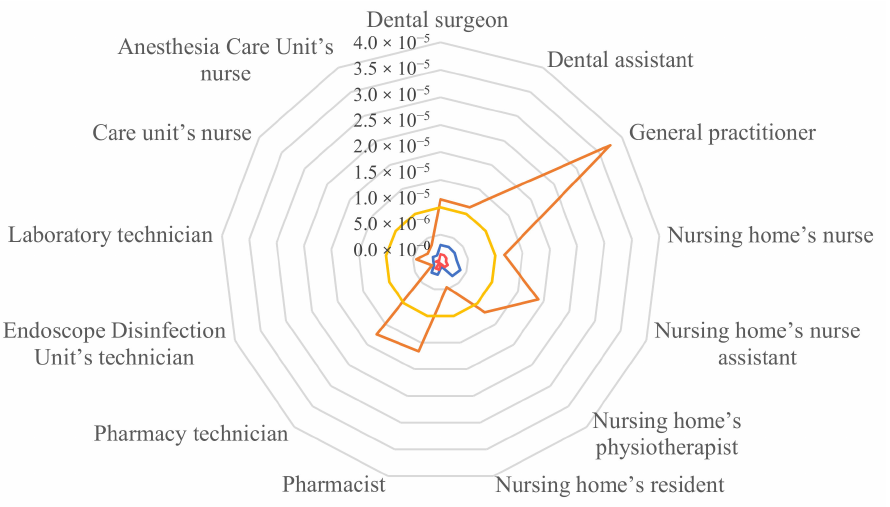
Figure 2. Excess lifetime cancer risks of benzene (blue), formaldehyde (orange) and acetaldehyde (red) against the acceptability threshold